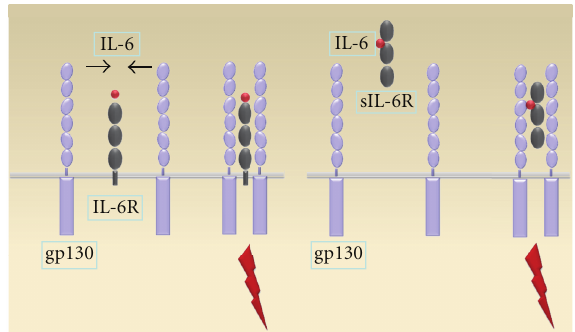
Figure 2: Model of gp130 transsignaling. IL-6 signaling occurs by binding its membrane bound receptor (IL-6R) in target cells and subsequent dimerization of gp130 (Figure on the left). Cells which do not express IL-6R can also be susceptible to IL-6 via soluble IL- 6 receptors that dimerize with membrane bound gp130 (Figure on the